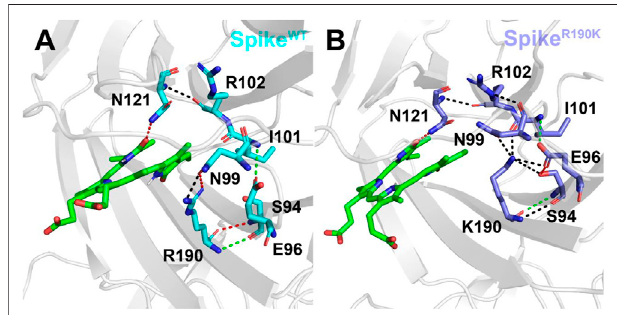
FIGURE 5 | Hydrogen bond analysis around the amino acid at position 190 in the Spike WT /Biliverdin (A) and Spike R190K /Biliverdin (B) . Three different colors, red, green, and black, representing strong, moderate, and weak hydrogen bond interactions, were applied according to their probability range of > 80%, 60% – 80%, and 30% – 60%,